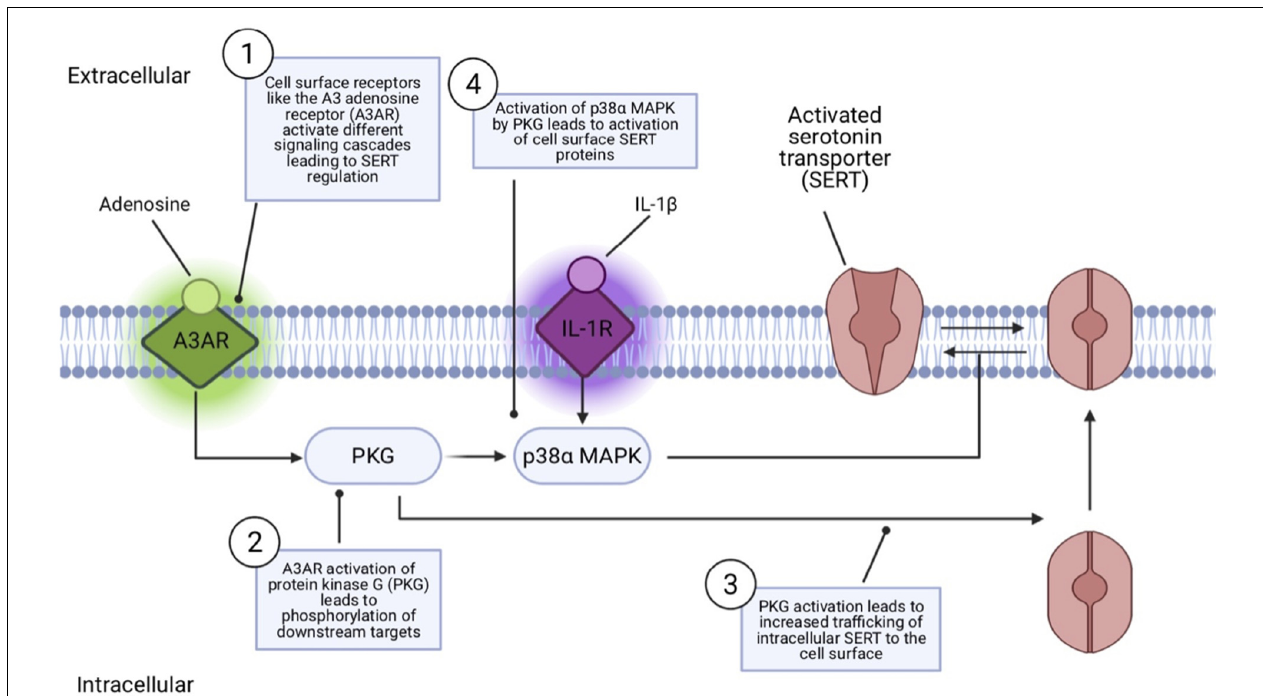
FIGURE 2 | Model of receptor-mediated SERT regulation. Cell surface receptors like the adenosine receptor (A3AR) can regulate SERT via a protein kinase G (PKG) pathway that can both mobilize intracellular SERT proteins to move to the cell surface and, via a second, p38 α MAPK-linked pathway, activate surface transporters to rapidly increase 5-HT transport rates. IL-1R stimulation by the inflammatory cytokine Il-1 β can lead to SERT activation via PKG-independent p38 α MAPK stimulation, without impacting SERT surface